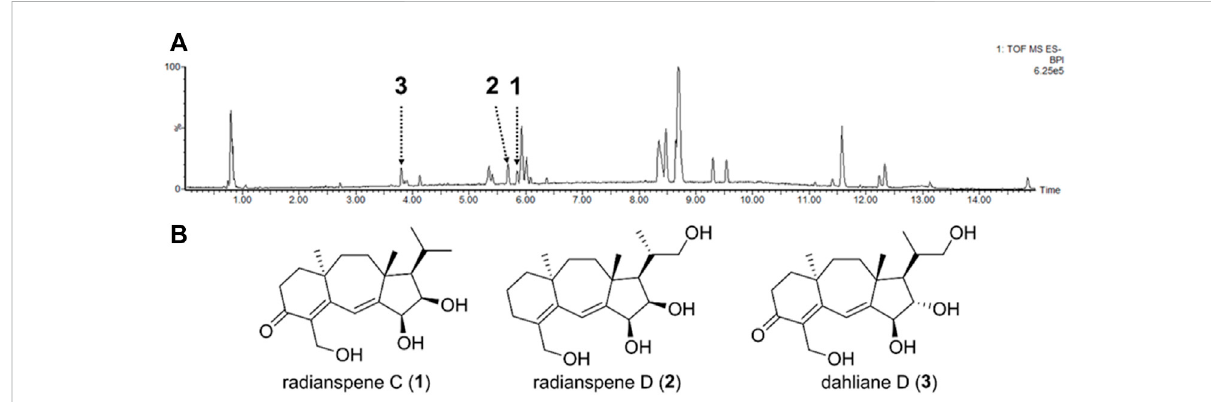
FIGURE 2 Chemical structures of radianspenes C and D, and dahliane D. (A) LC-MS base peak ion chromatogram (negative ion mode) of the Nemania sp. EL006872 crude extract. The isolated compounds were denoted. It should be noted that the intensities of chromatographic peaks do not represent absolute quantity of each compound, because the MS signal intensity is heavily affected by ionization ef fi ciency of each molecule. (B) Chemical structures of radianspenes C and D, and dahliane D.